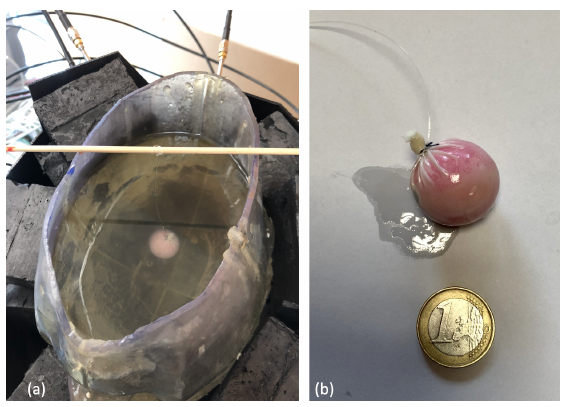
Figure 6. ( a ) Experimental set-up; ( b ) 1.25 cm-radius plastic sphere.